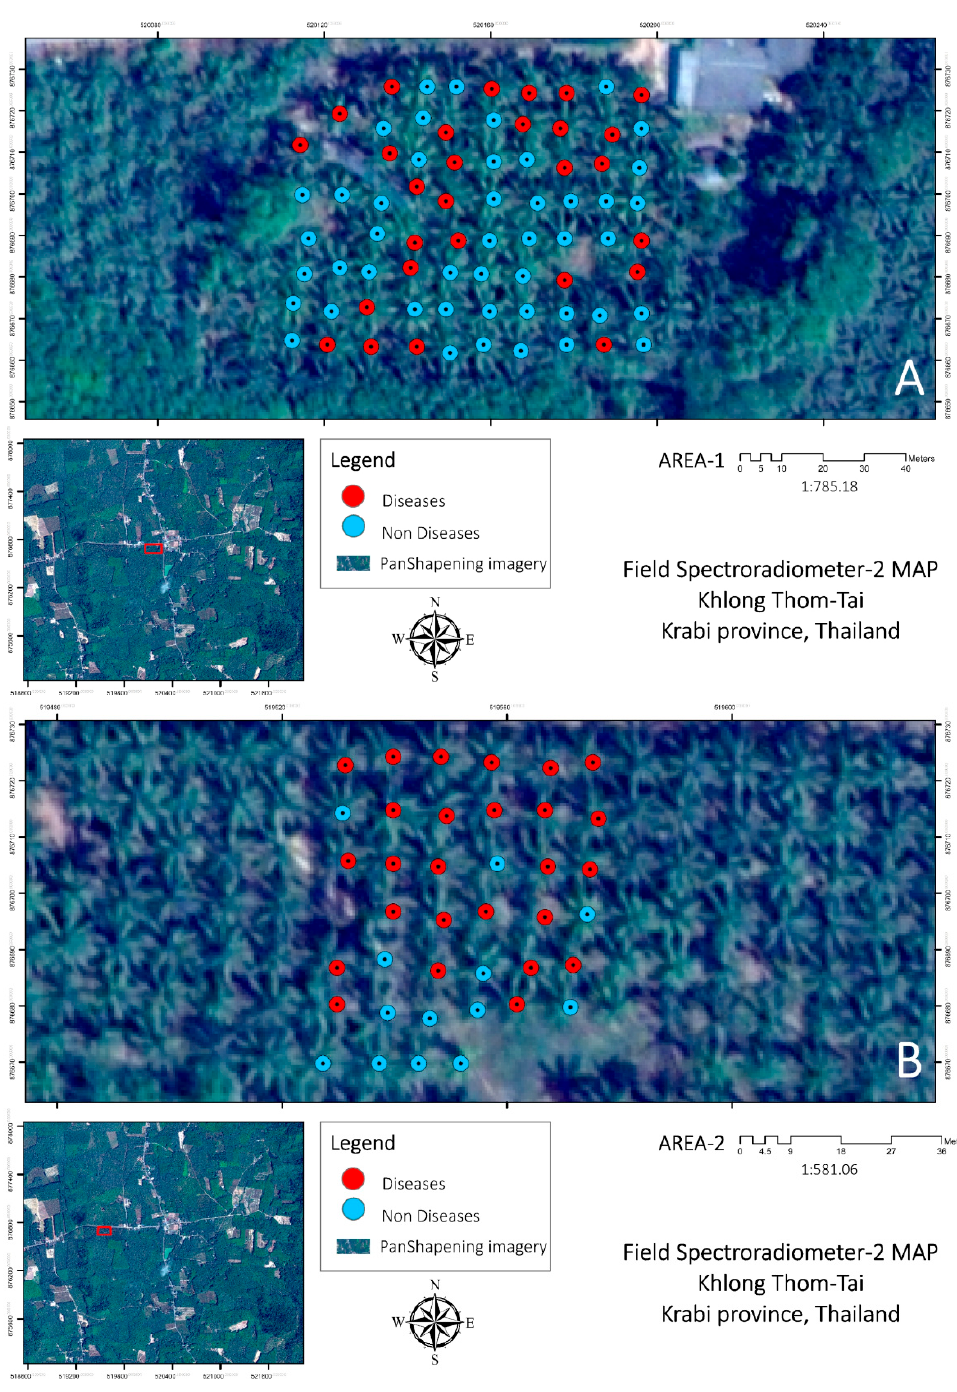
Figure 6. Geo-location of diseased (red circle) and healthy oil palm trees (blue circle) on which hyperspectral samples with an Field Spec Handheld spectroradiometer were collected in Area 1 ( A ) and Area 2 ( B ) in Khlong Thom-Tai Krabi, Thailand.